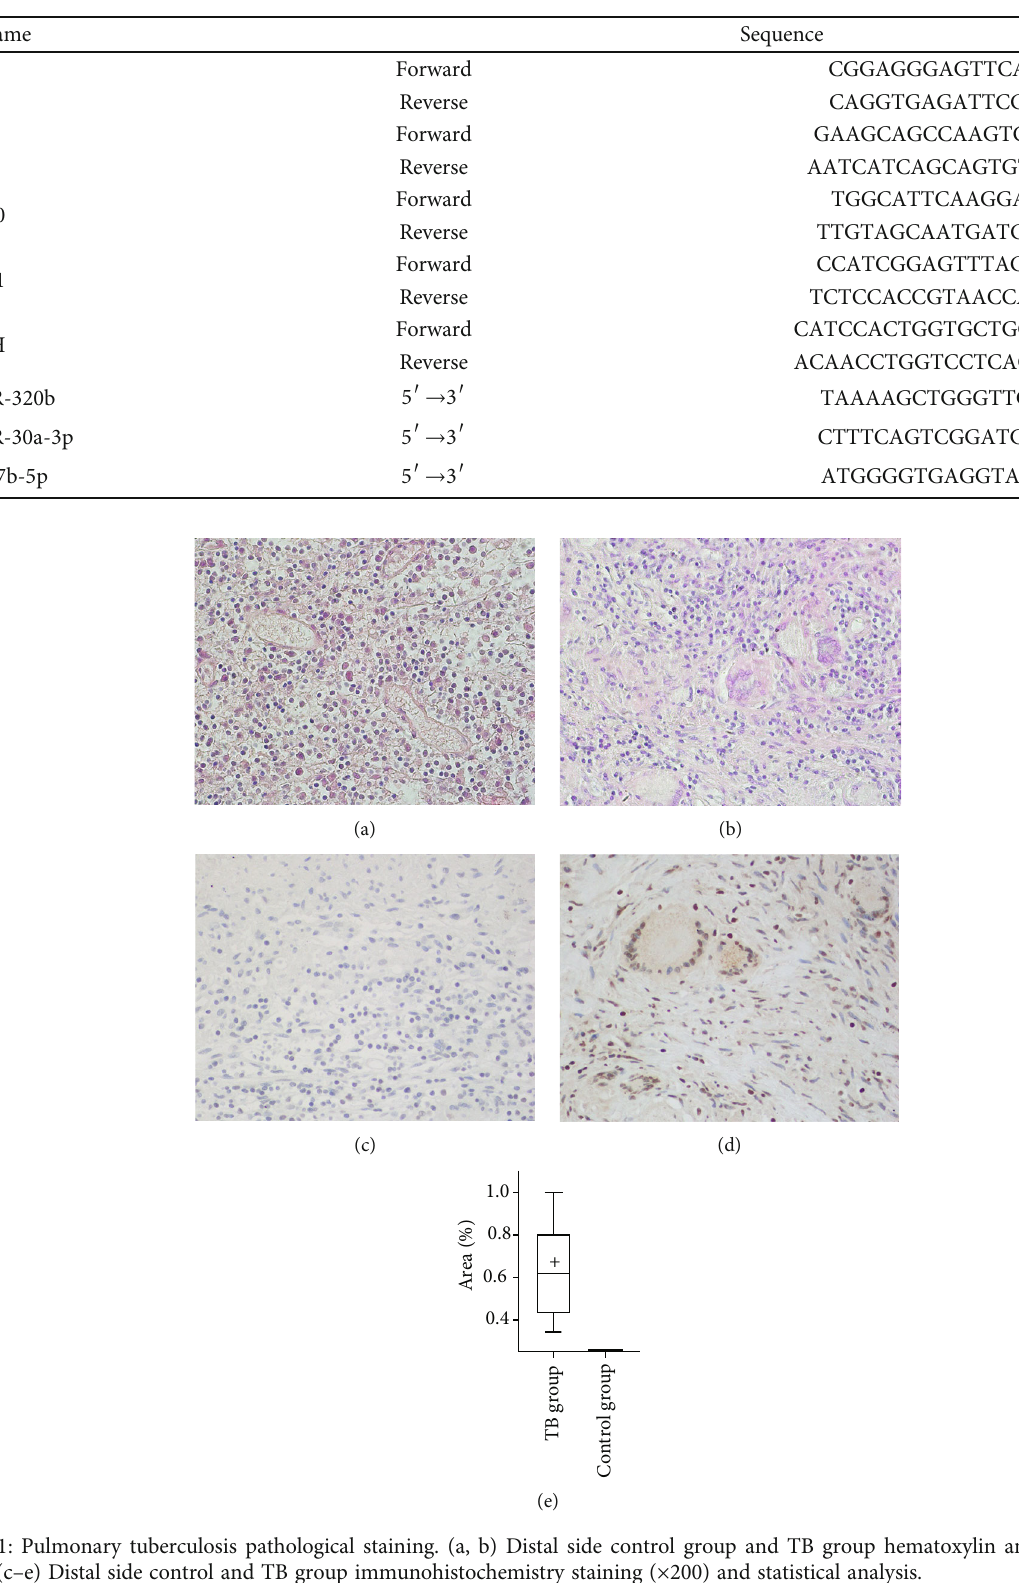
Table 2: Primer sequences.